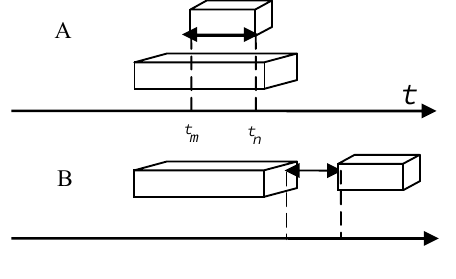
Fig. 4. A The time overlap between two MBBs, B The minimal space distance between two